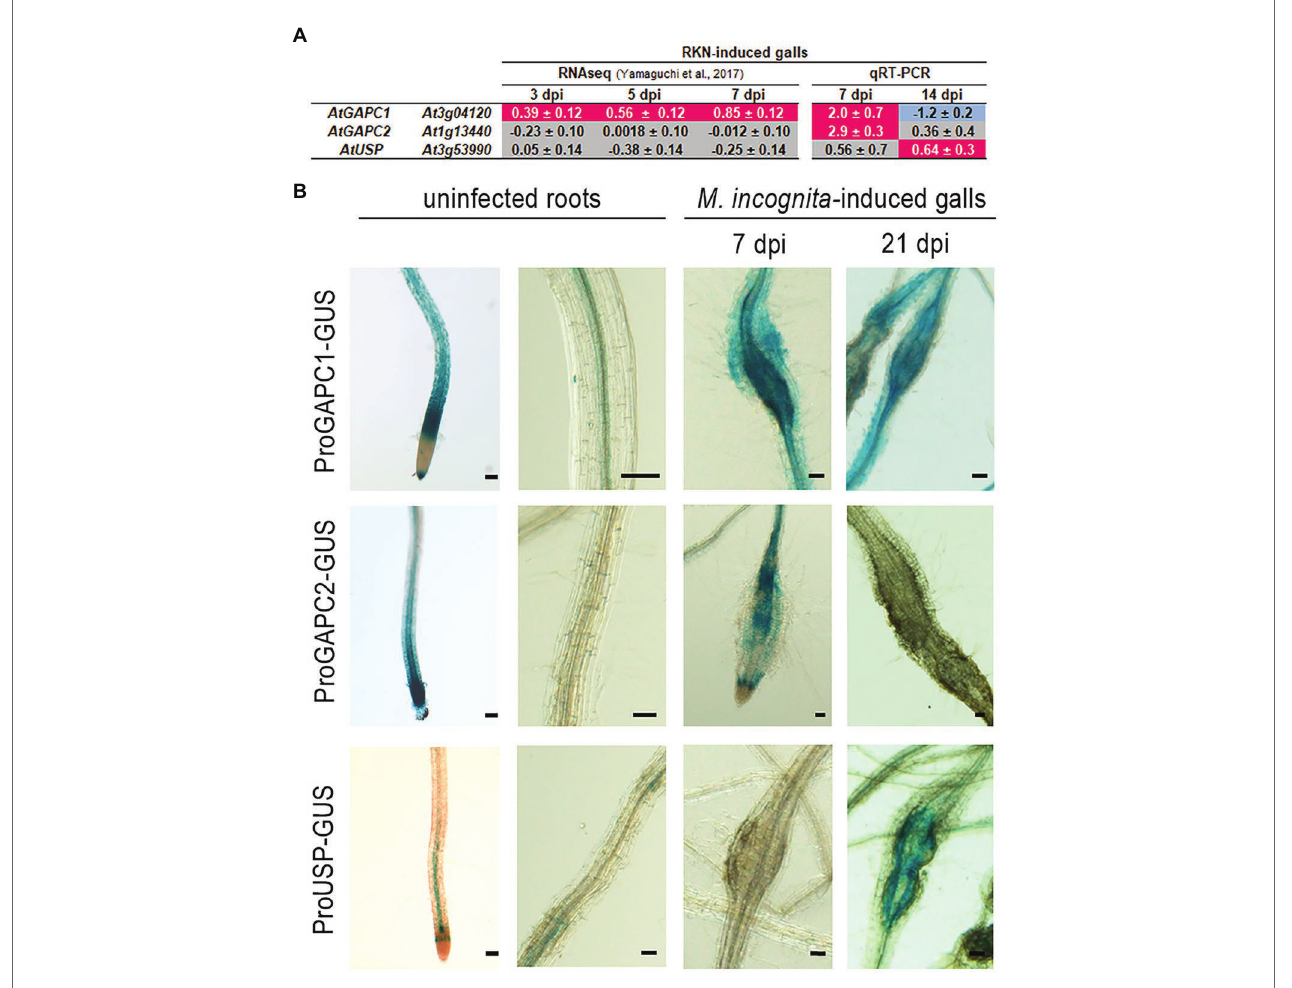
FIGURE 3 | MiEFF1-interacting proteins accumulate in RKN-induced feeding sites. (A) Expression ratios of the AtUSP , AtGAPC1 , and AtGAPC2 genes in galls vs. uninfected roots (log2) were obtained from RNAseq (Yamaguchi et al., 2017) data. Data presented are log2 fold changes ± standard deviation (SD) from three biological replicates. The mRNA expression level of these genes was further measured by quantitative real-time PCR (RT-qPCR) in galls at 7 and 14 days post M. incognita infection (dpi) and uninfected roots. Data were normalized against OXA1 and UBP22 as constitutive genes. Data presented are log2 fold changes ± SD from two biological replicates. dpi, days post-infection. Gray coloring indicates an absence of differential expression, a magenta coloring indicates an upregulation and a blue coloring a downregulation. (B) GUS expression in galls at 7 and 21 dpi, and uninfected roots, of plants transformed with AtGAPC1 , AtGAPC2 , and AtUSP promoter –GUS fusions. Reporter GUS expression in galls was revealed following 2 h ( AtGAPC1promoter::GUS ) or 16 h ( AtGAPC2promoter::GUS and AtUSPpromoter::GUS ) staining. Two to three independent experiments were performed with similar results. NI, not infected. Bars = 50 μ